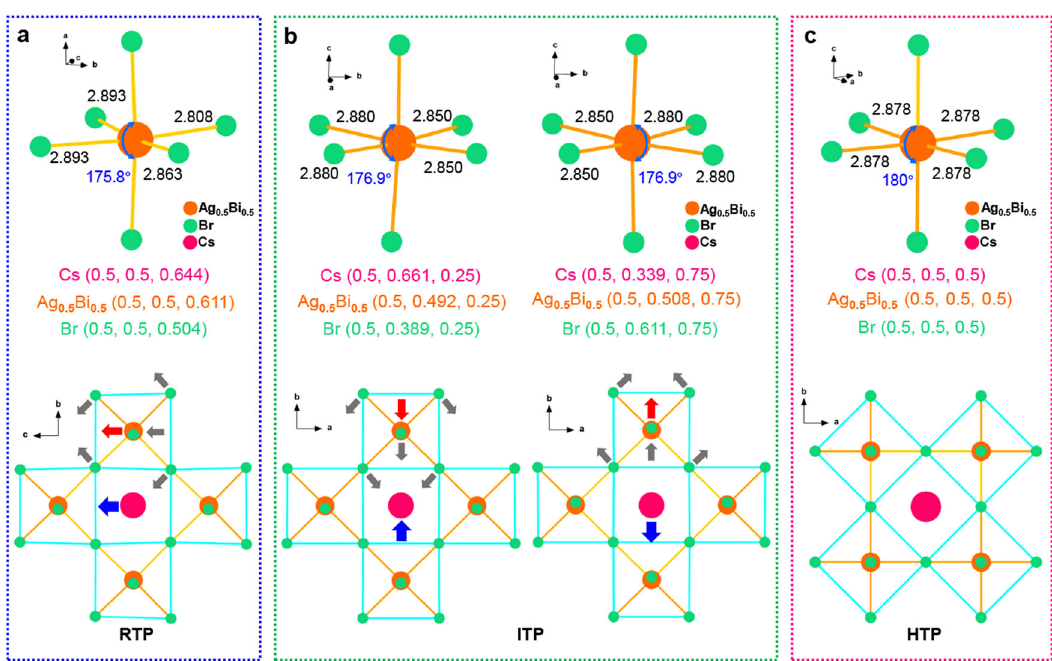
Fig. 4 | Schematicdiagramfor the axialdistortionofthe Ag/BiBr 6 octahedra of1. The shift value of Br − , Cs + and Ag + /Bi 3+ ions are presentedat a LTP, b ITPand c HTP.